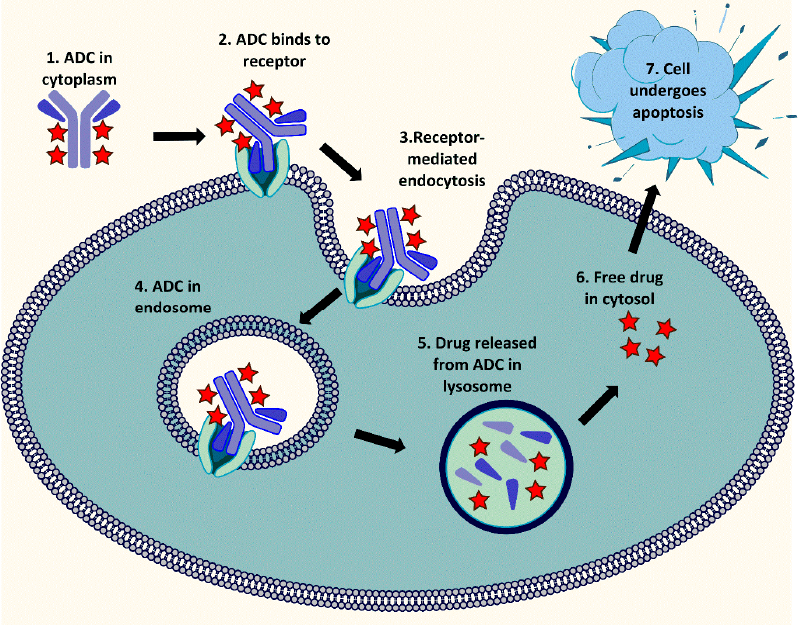
Figure 2. General mechanism of action of ADCs. The antibody of an ADC binds to tumor associated antigen. Upon binding, the ADC-antigen complex is internalized into the cancer cell. During the degradation of the complex, the released payload exerts its effects on the intracellular target leading to